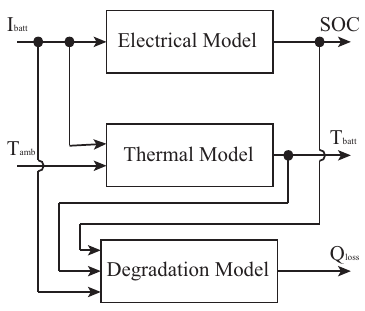
Figure 3. A schematic of a control-oriented battery model.